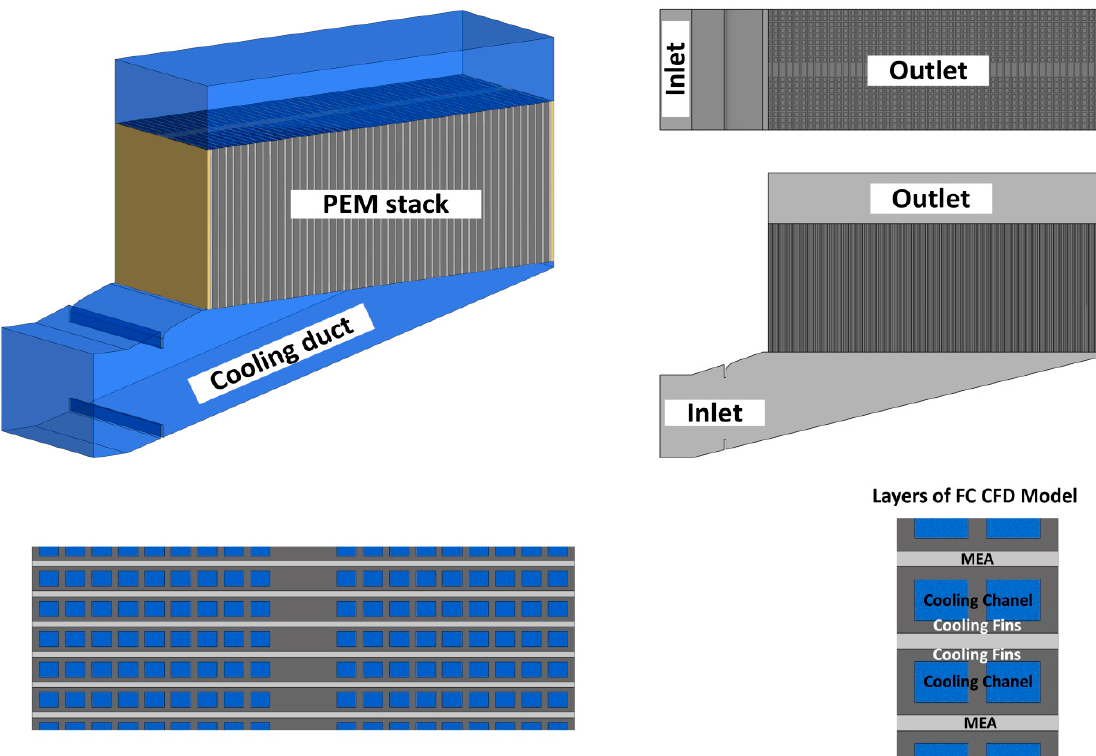
Figure 11. Geometric model of NEXA PEMFC stack used for computational fluid (CFD) simulation and optimization.